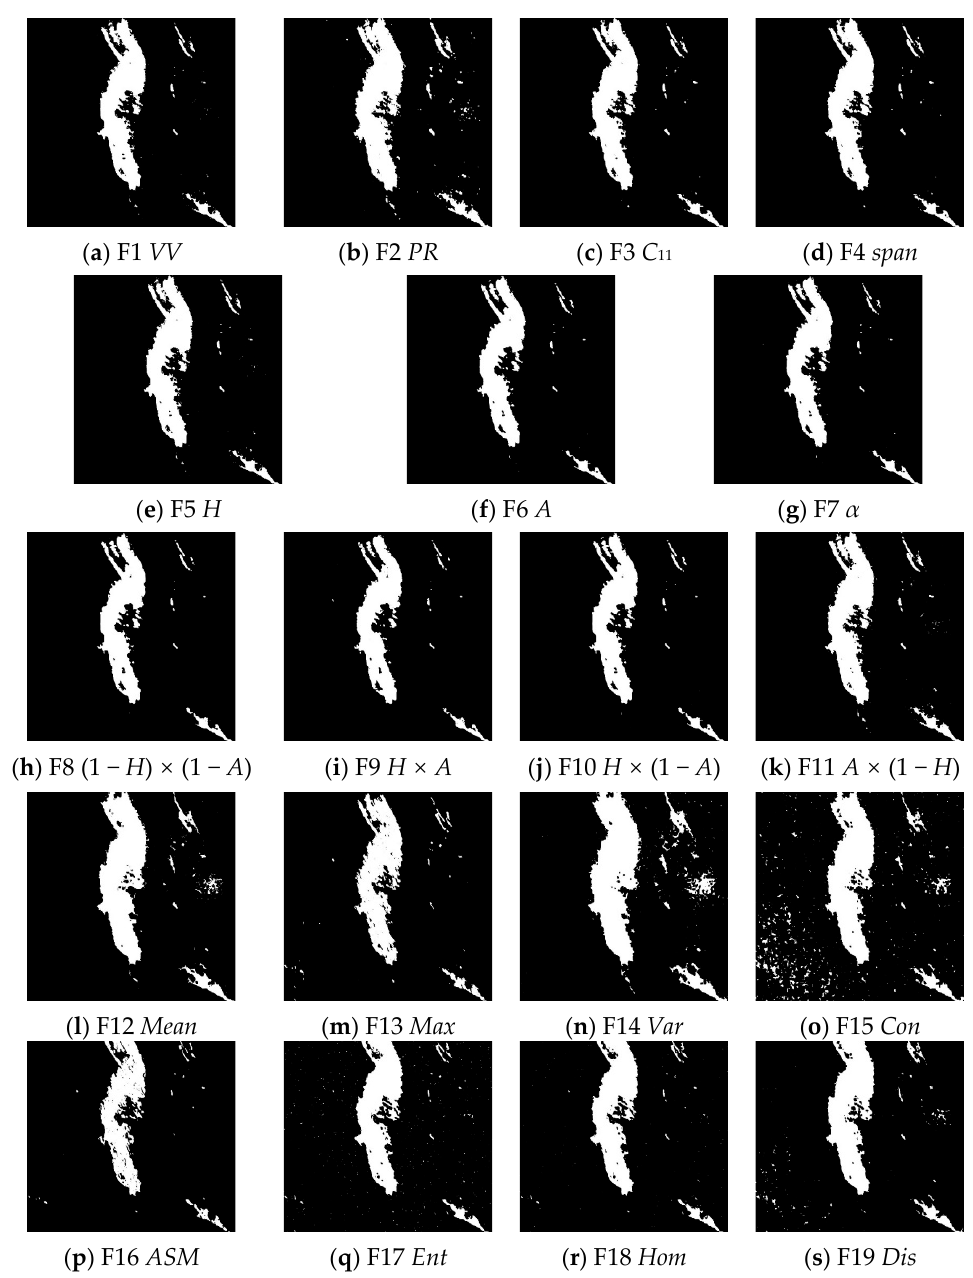
Figure 9. Image segmentation result for data b based on J–M/K-means algorithm.